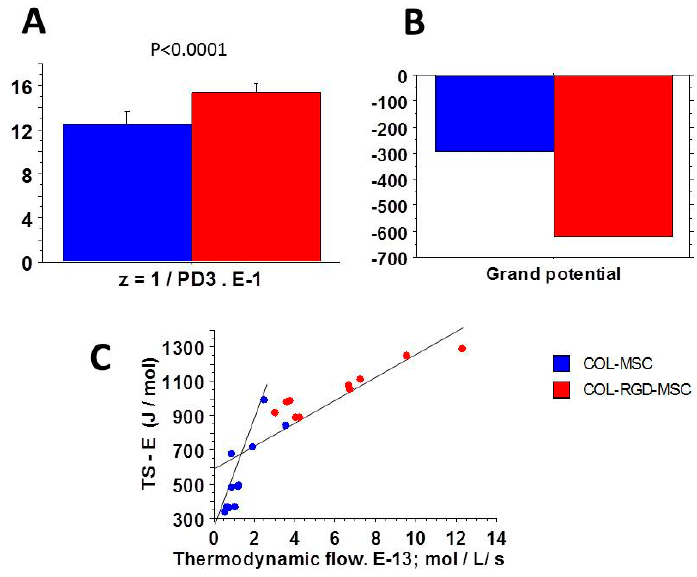
Figure 2. Parameters of statistical mechanics. ( A) : the microcanonical partition function (z) was significantly greater in COL-RGD-MSC scaffolds (red) than in COL-MSC scaffolds (blue); ( B) : the grand potential was significantly greater in COL-MSC-RDG scaffolds than in COL-MSC scaffolds; ( C ): there was a linear relationship between (TS-E) and the thermodynamic flow. When the thermodynamic flow tends towards zero, the chemical affinity tends towards zero and (TS-E) represents the value of the grand potential; y = 295 + 200 x, r = 0.84 in COL-MSC scaffolds; y = 620 +45x, r = 0.95 in COL-MSC-RGD scaffolds.